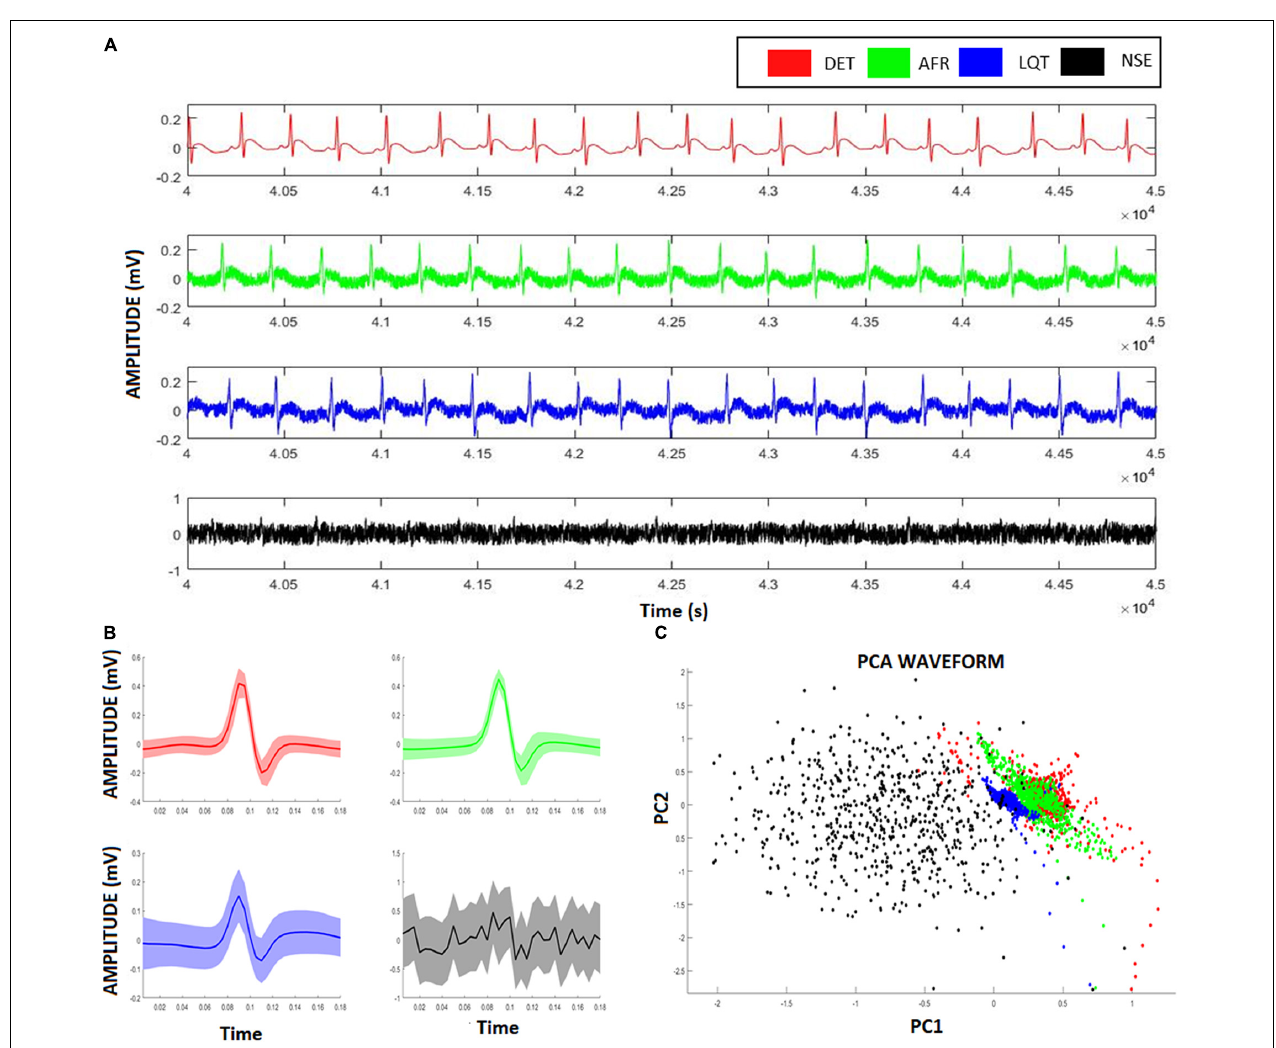
FIGURE 3 | Artificial ECG patterns. (A) Red signals represent the deterministic aECG, the green signal represents the atrial fibrillation (AF) pattern relative to the aECGs, the blue signal represents the long-QT (LQT) syndrome pattern relative to the aECGs, the black signal represents a deterministic aECG signal embedded of high noise (NSE). (B) The correspondent PQRST-complexes from each aECG model, showing their average and confidence interval. (C) Scatter-plot relative to the two first scores from a Principal Component Analysis (PCA) considering all four ECG-complexes shown in (B). Despite the clusters formed from different groups overlaps each other, it is still possible to identify and distinguish the groups from their